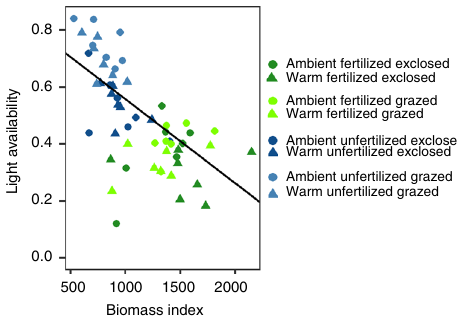
Fig. 2 Community biomass and light availability. Relationship between total community biomass index in 2014, expressed as hits per 100 pins in 25 × 50 cm 2 quadrats, and light availability measured as proportion of PAR penetrating through vegetation (linear regression, F 1,54 = 39.79, P < 0.001, R 2 = 0.41, n = 56). Warmed plots are indicated by triangles, unwarmed plots (with ambient temperature) by circles. Fertilized plots are shown in green , unfertilized in blue . Herbivore exclosures are indicated with dark color , grazed plots in light